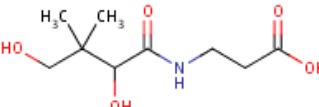
Figure 10. Riboflavin structure. 4.8. Immunological, Antioxidant and Neurological Mechanism Pyridoxine (Vitamin B 6 ), structurally shown in Figure 11, enhances immunity integrity via the linkage formation between chemokines and cytokines, while it enhances immune feedback towards increased antibody output [101]. Dietary pyridoxine exhibits antioxidant activity via the inhibition of erythrocytic lipid peroxidation [102] and reduces the predispositionary risk to stroke and arteriosclerosis. It is involved in synthesizing haemoglobin and neurotransmitters as well as gluconeogenesis [97,103]. Pyridoxine controls the risk of acute coronary syndrome and athero- thrombosis by modulating blood homocysteine levels [104].